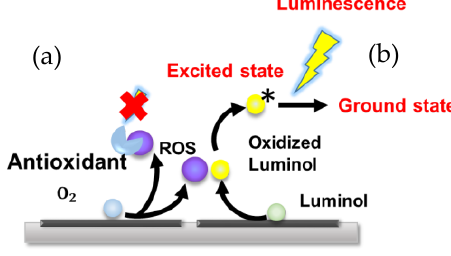
Figure 2. The scheme of the principle of the luminol luminescence and quenching by antioxidant ( a ) Quenching scheme in presence of antioxidant; ( b ) Scheme of Luminol luminescence with self ROS generating